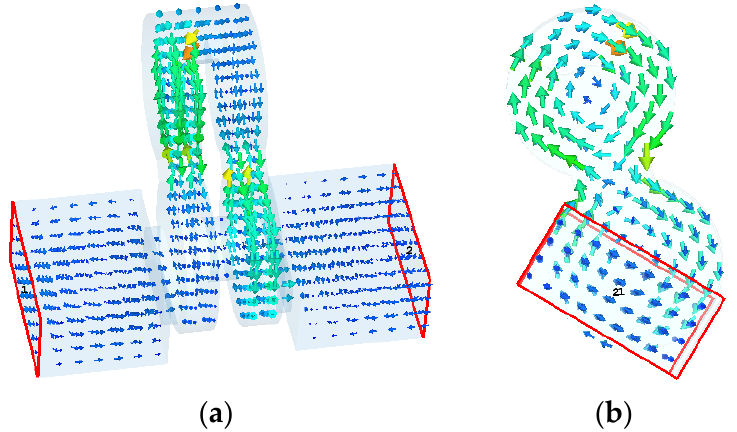
Figure 3. Magnetic field distribution map of the designed structure. ( a ) Front view of the designed filter ( b ) Left side view of the designed filter.